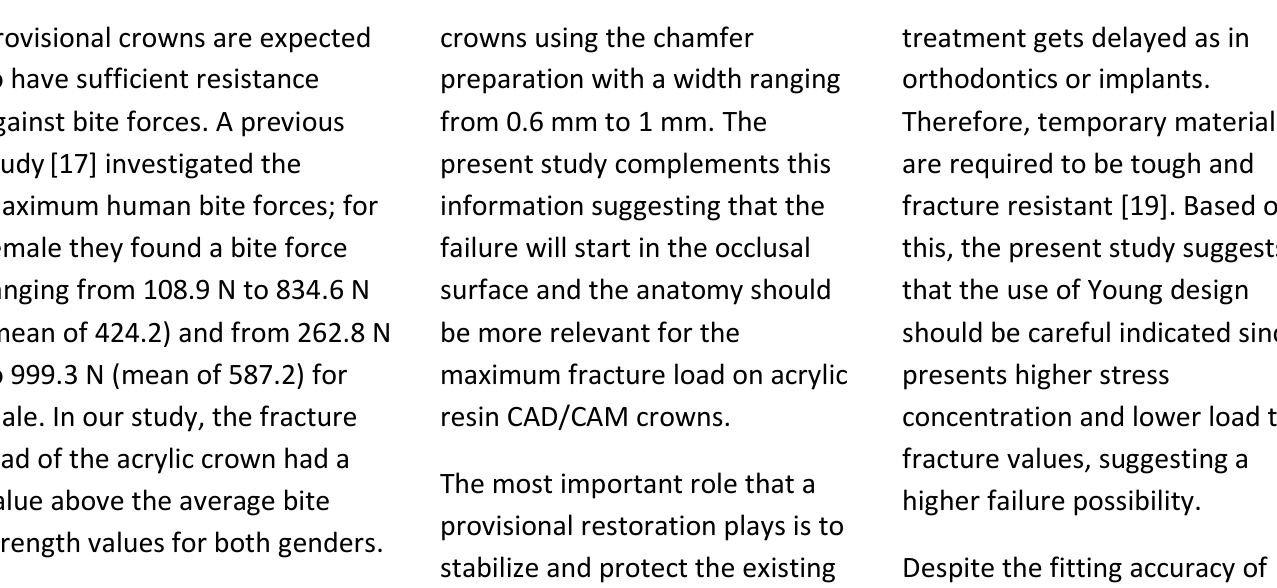
Figure 4. Maximum principal stress maps results for the restoration with A-C) Adult design and D-F) Young